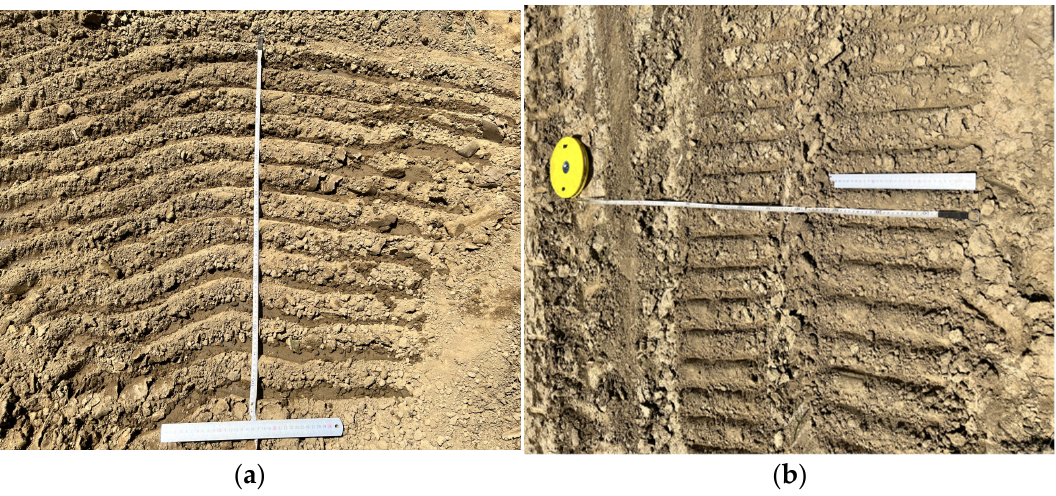
Figure 13. Track rolling trace: ( a ) Differential steering chassis and ( b ) Rear axle steering chassis.